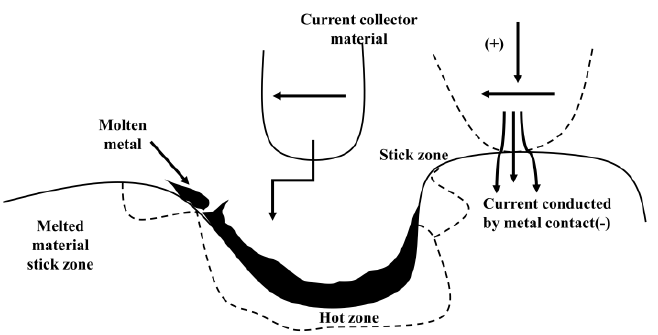
Figure 14. A schematic diagram of the current-carrying friction and wear model.